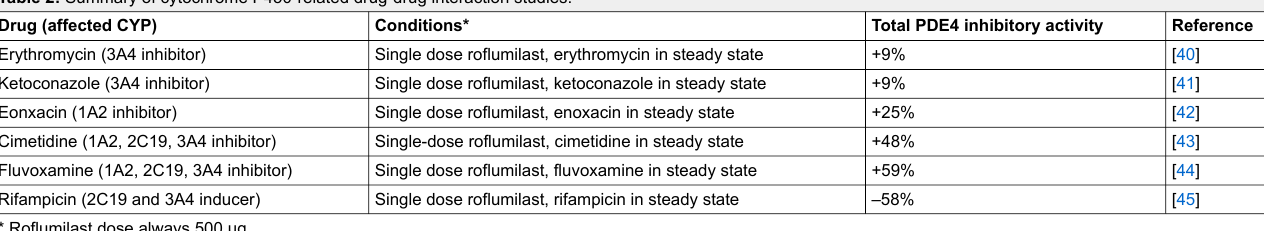
Table 2: Summary of cytochrome P450-related drug-drug interaction studies. Drug (affected